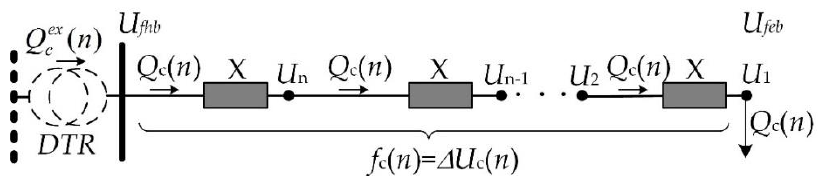
Figure 5. Equivalent circuit of a LV feeder with a concentrated var-sink.